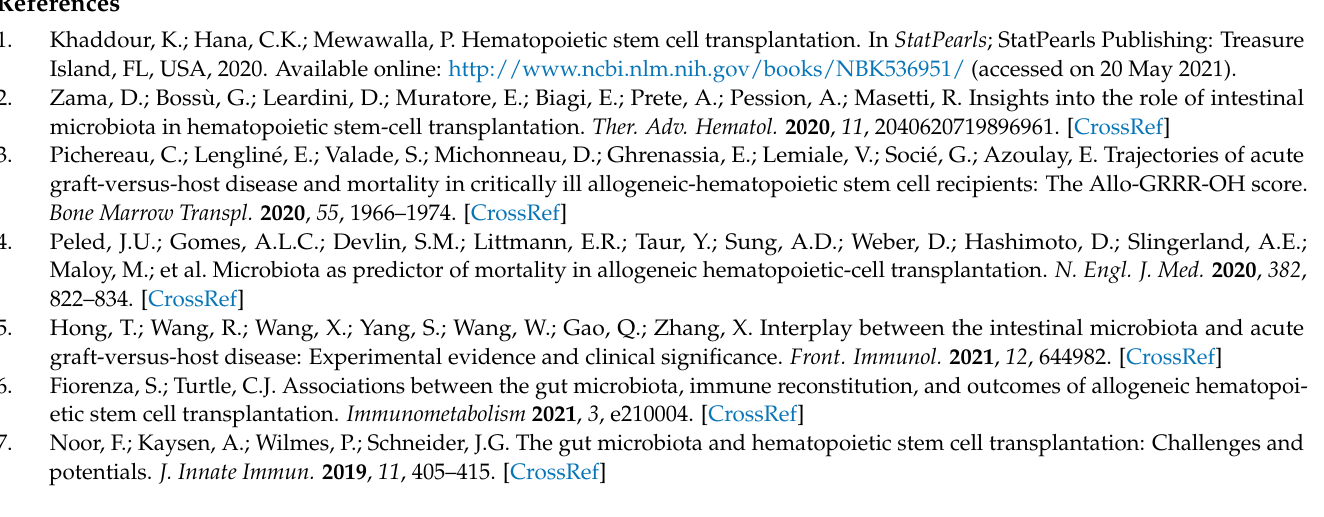
Figure S7: Heatmap showing the distribution of metabolites among patients and control groups. Figure S8: The permutation test plots for the OPLS-DA models for the classification of allo-HSCT and CT groups with 200 permutation tests. Figure S9: The permutation test plots for the OPLS-DA models for the classification of the GvHD and no-GvHD groups with n = 100 permutation tests. Figure S10: Fecal metabolic differences among groups: heatmaps of differential metabolites among the groups. Table S1: Clinical and demographic data of the allo-HSCT patients. Table S2: Alpha diversity indexes of fecal samples of allo-HSCT recipients. Table S3: Mean relative abundances of the seven most abundant bacteria at the genus level present in the fecal specimens of 15 allo-HSCT patients and 18 control subjects. Table S4: Mean relative abundances of the eight most abundant bacteria at the genus level present in the fecal specimens of allo-HSCT recipients suffering or not from graft-versus-host disease. Table S5: Topological properties of networks in fecal communities of healthy and allo-HSCT transplant samples with and without GvH disease. Table S6: Summary of the detected metabolites in the feces of the allo-HSCT and CT groups. Table S7: Biomarkers identified in fecal metabolic profiles of the allo-HSCT group vs. the CT group. Table S8: Selected biomarkers identified in fecal metabolic profiles of the allo-HSCT group vs. the CT group. Table S9: Changes in the metabolite levels in GvHD and non-GvHD patients compared to the CT